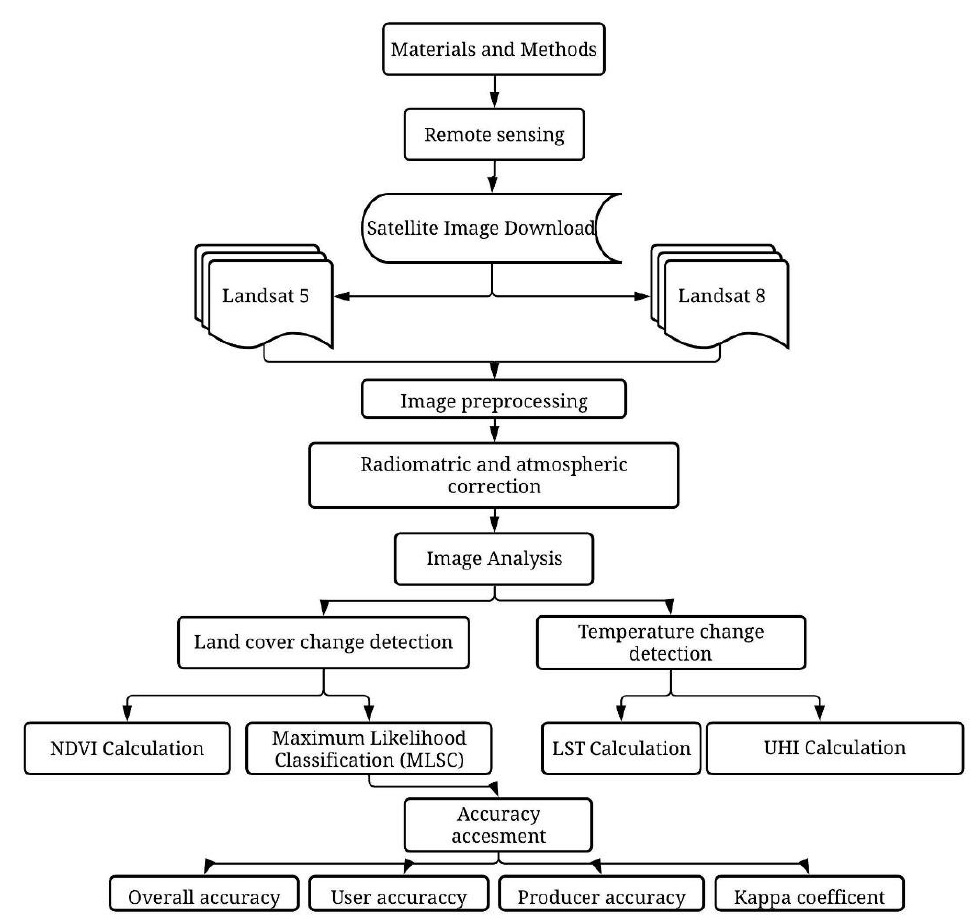
Figure 1. Methodological flowchart of the study area .